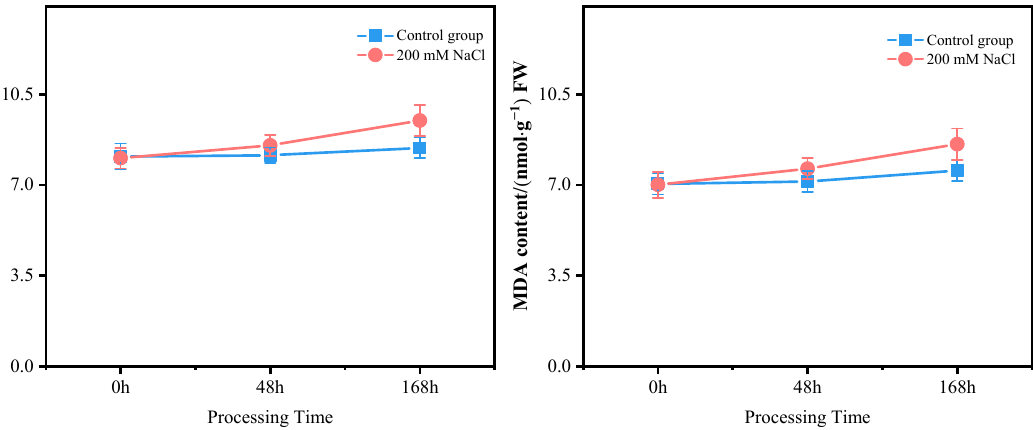
Figure 1. Change in antioxidative enzyme activity of T. ramosissima roots under NaCl stress. (Changes in SOD, POD, and CAT activities in the roots of T. ramosissima at 0, 48, and 168 h under NaCl stress).